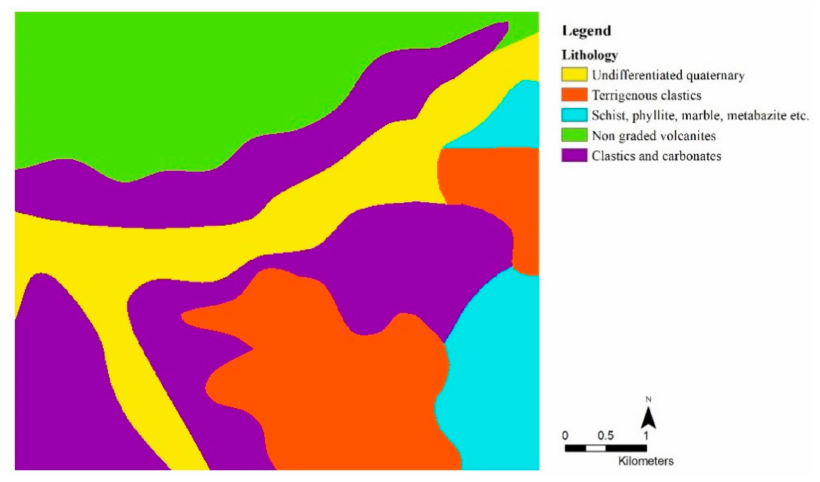
Figure 10. Lithology map of the study area